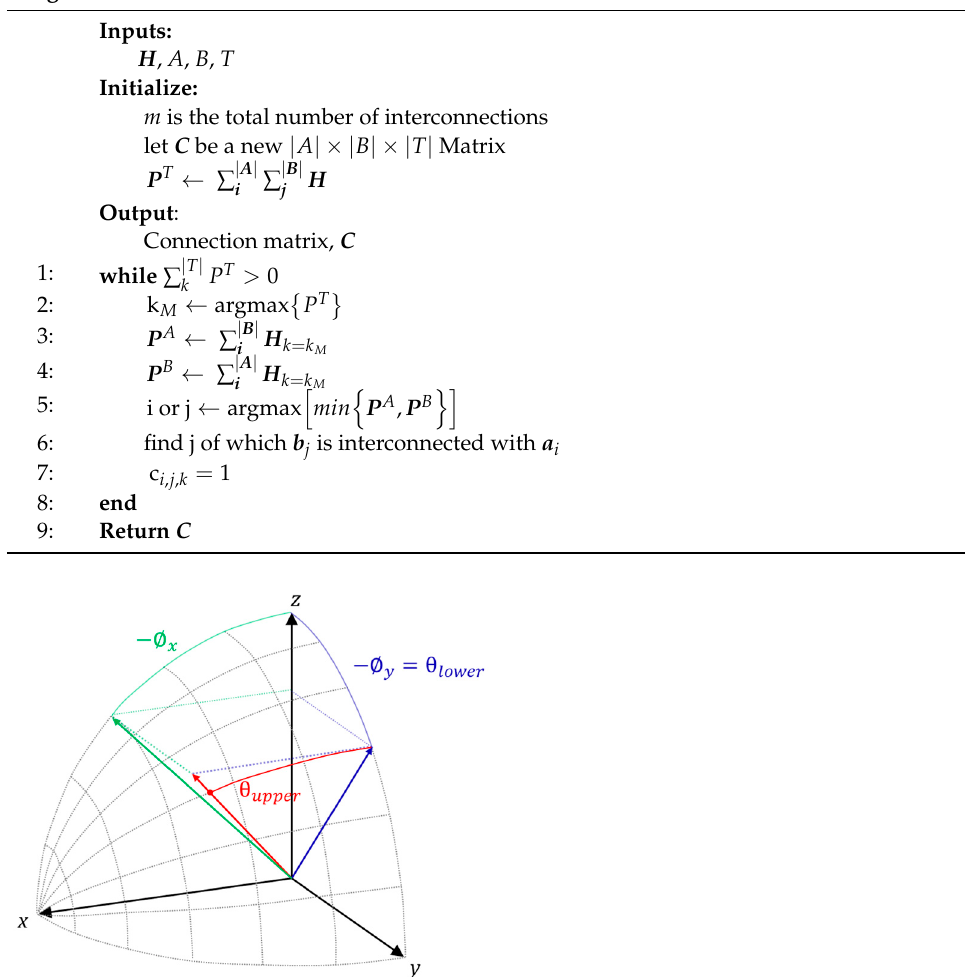
Algorithm 2: Get Interconnection Matrix.